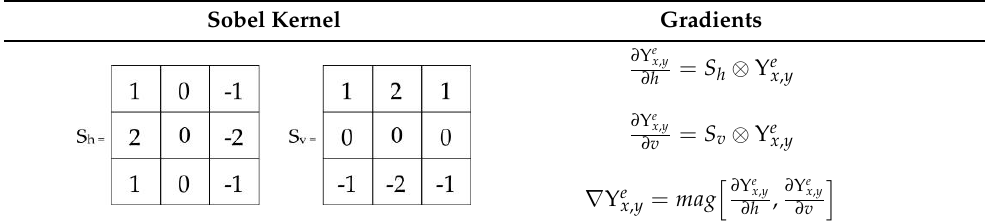
Table 3. Sobel filter operation. Sobel